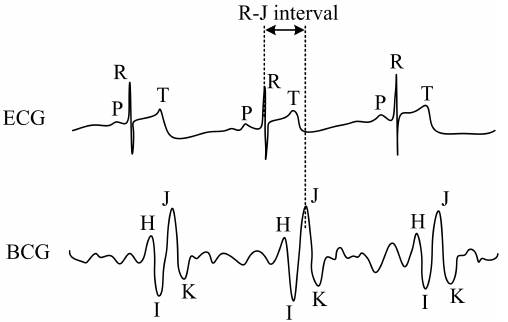
Figure 6. Sample recordings of electrocardiogram (ECG) and Ballistocardiography (BCG) signals.